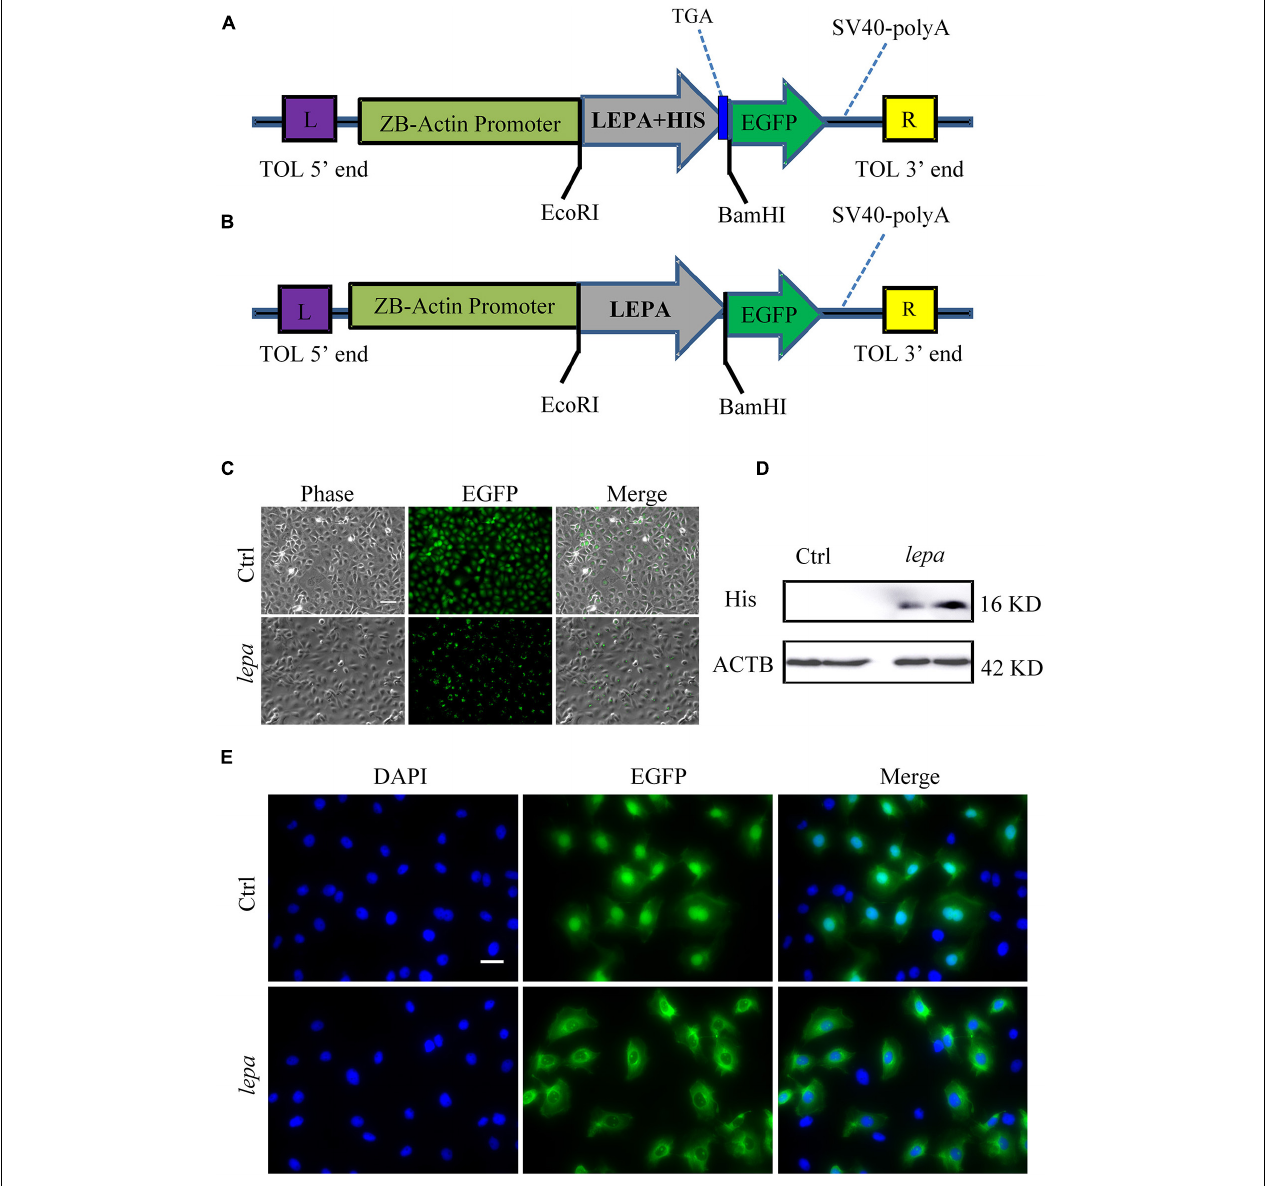
FIGURE 4 | Over-expression of DM-lepa in ZFL cells. (A,B) DM-Lepa expression vector map. (C) Fluorescence observation after transfection of ZFL cells with empty plasmid and DM-lepa gene eukaryotic expression plasmid. Scale bar, 50 µ m. (D) Western blot analysis of DM-LEPA in ZFL. (E) Assay of subcellular localization in ZFL cells. Green fluorescence show signal of DM-LEPA and blue nuclei stained with DAPI. Scale bar, 20 µ